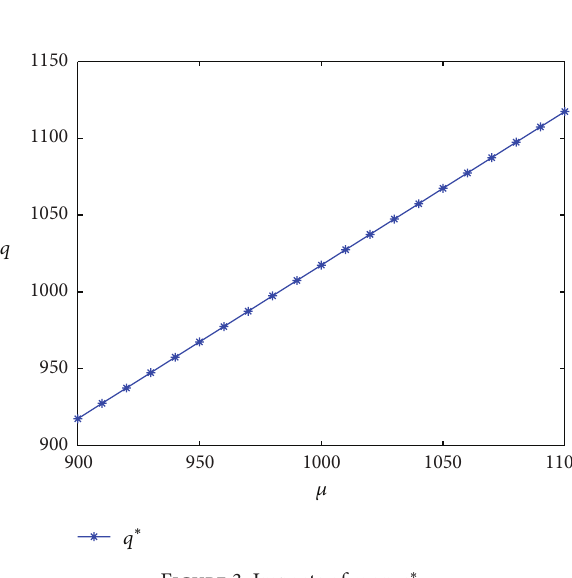
Figure 2: The case of 𝑧 < 𝑞 .